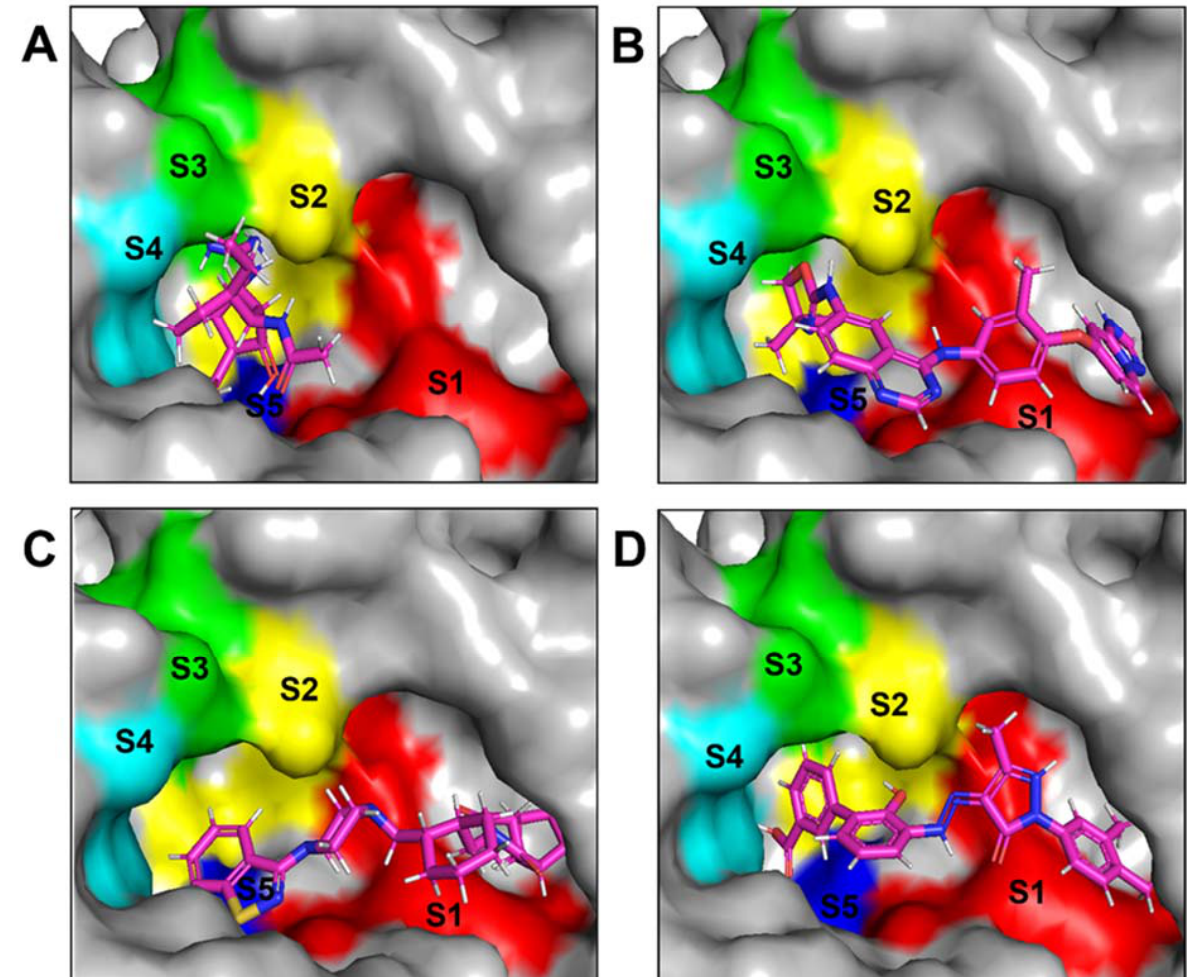
Figure 2. Binding modes of NA in complex with peramivir ( A ), lurasidone ( B ), tucatinib ( C ), and Promacta ( D ).